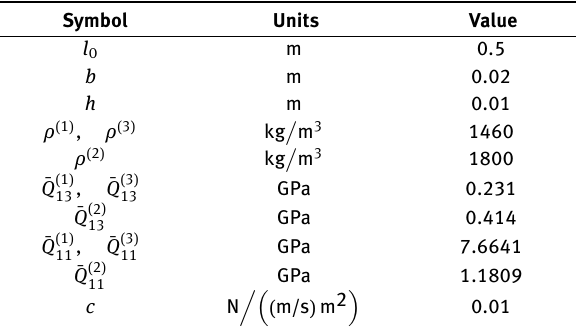
Table 1. Geometric and material parameter values of the three-layer composite cantilever beam